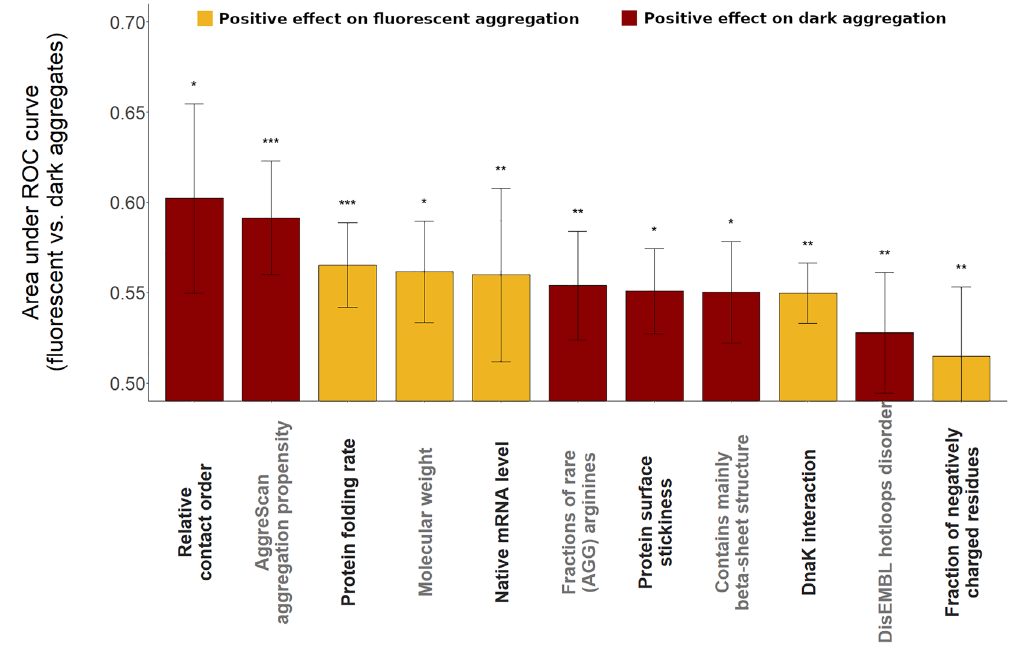
Figure 3. Protein features distinguishing between slowly and rapidly aggregating proteins. Features discriminating between proteins that form dark (rapid) versus fluorescent (slow) aggregates. The predictive ability of each feature was measured as the average area under the receiver operating characteristic (ROC) curve in a tenfold cross-validation procedure based on logistic regression analyses. All displayed protein features are statistically significantly predictive after adjustment for multiple testing using the false discovery rate method, ** corresponds to p_adj < 0.01, * to p_adj < 0.05 (logistic regression). Error bars show the 95% confidence interval for the AUC value of each feature. Note that additional features with weaker discriminating ability are listed in Suppl. Table